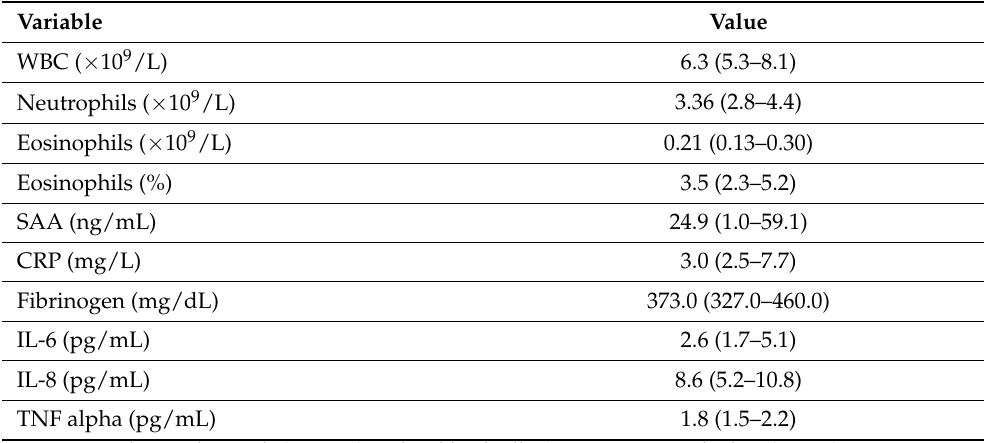
Table 2. Selected inflammatory parameters in peripheral